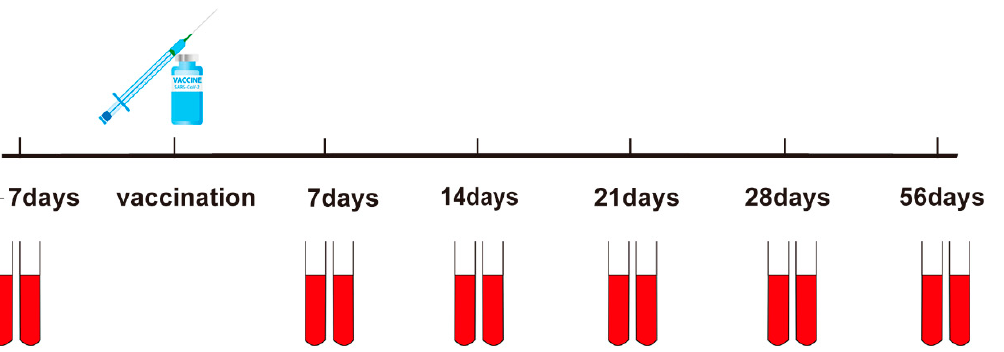
Figure 3. Time axes of samples collection and inoculation. − seven days, the seven days before the COVID ‐ 19 booster; seven days,14 days, 21 days, 28 days, and 56 days, The seven days, 14 days, 21 days, 28 days, and 56 days after the COVID ‐ 19 booster vaccine.